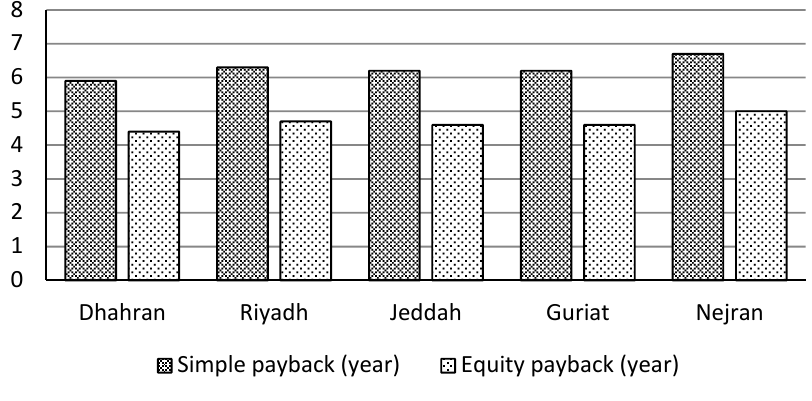
Figure 14. Simple and equity payback for all sites.